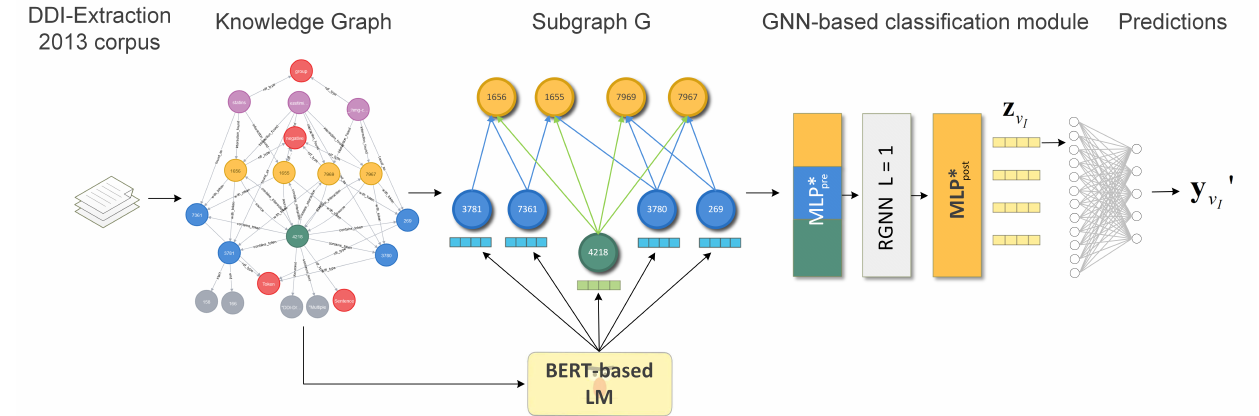
Figure 1. An overview of our proposed architecture for the classification of